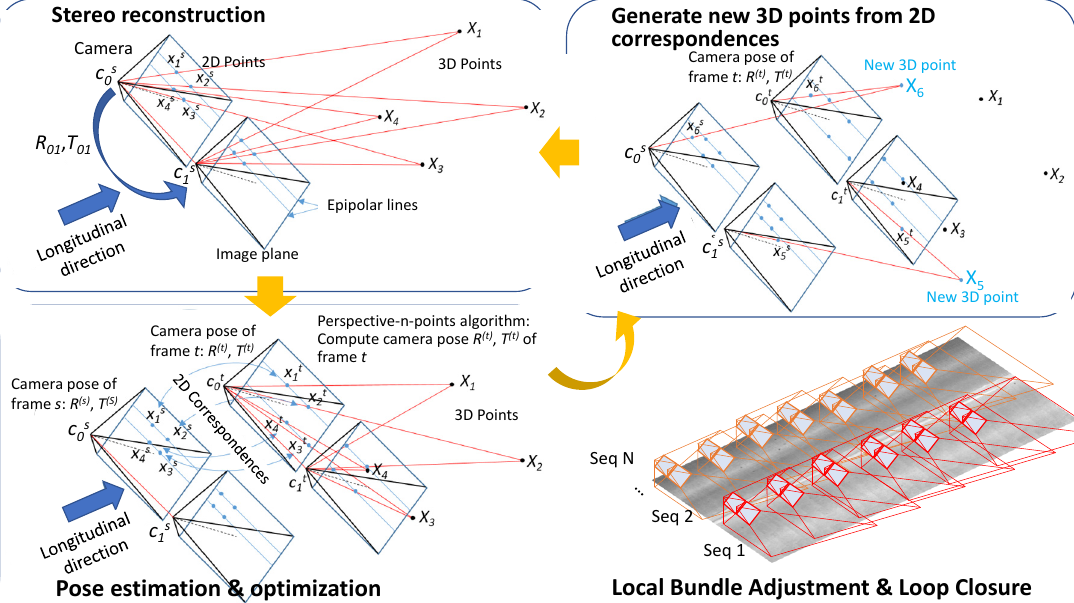
Figure 6. Image-based localization and mapping. Figure 6. Image-Based localization and